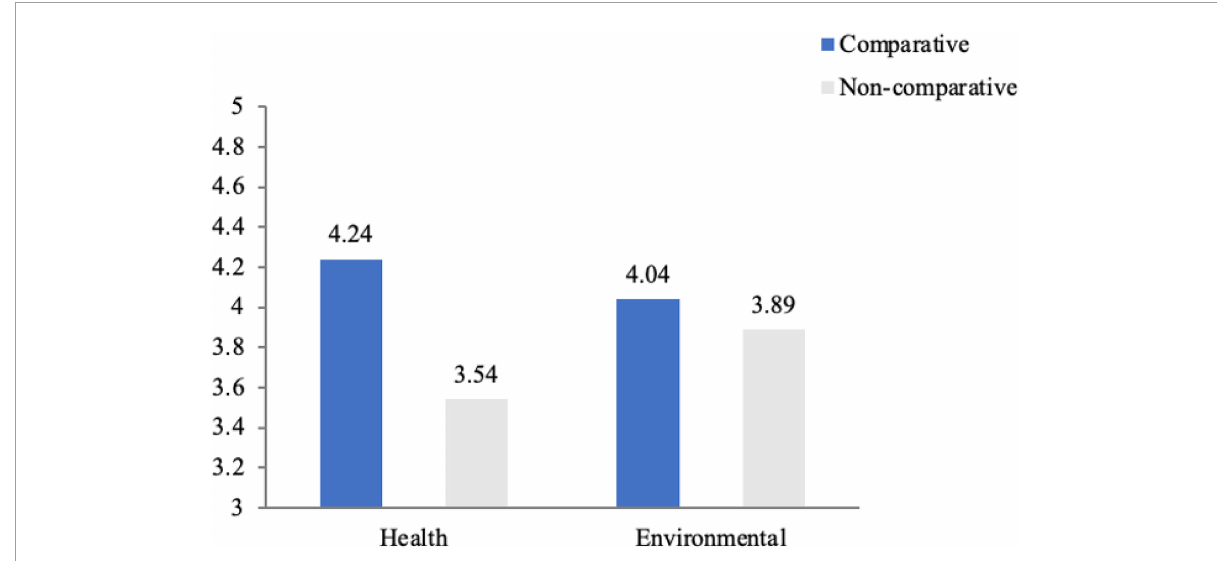
FIGURE3 Interaction effect between CA claims and benefit appeals on information